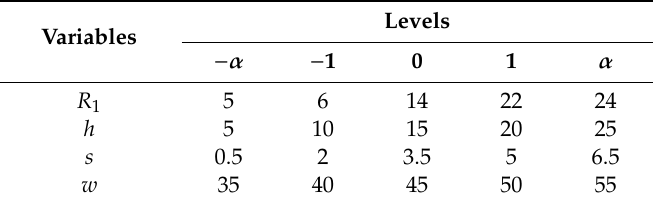
Table 5. Level of test factors by CCD.